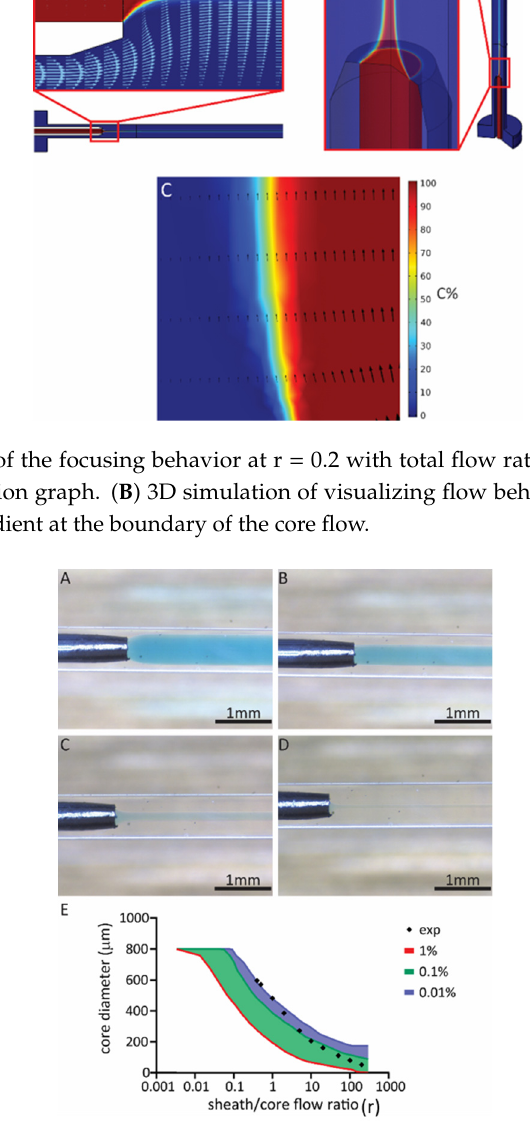
Figure 3. Core / sheath laminar flows in the microfluidic spinneret with constant total flow rate of 300 µ L / min and varied sheath / core flow ratio of ( A ) r = 0.5; ( B ) r = 2; ( C ) r = 20. ( D ) Core / sheath laminar flow with a total flow rate of 1000 µ L / min (r = 200). ( E ) Comparison of experimental values with simulated boundaries.